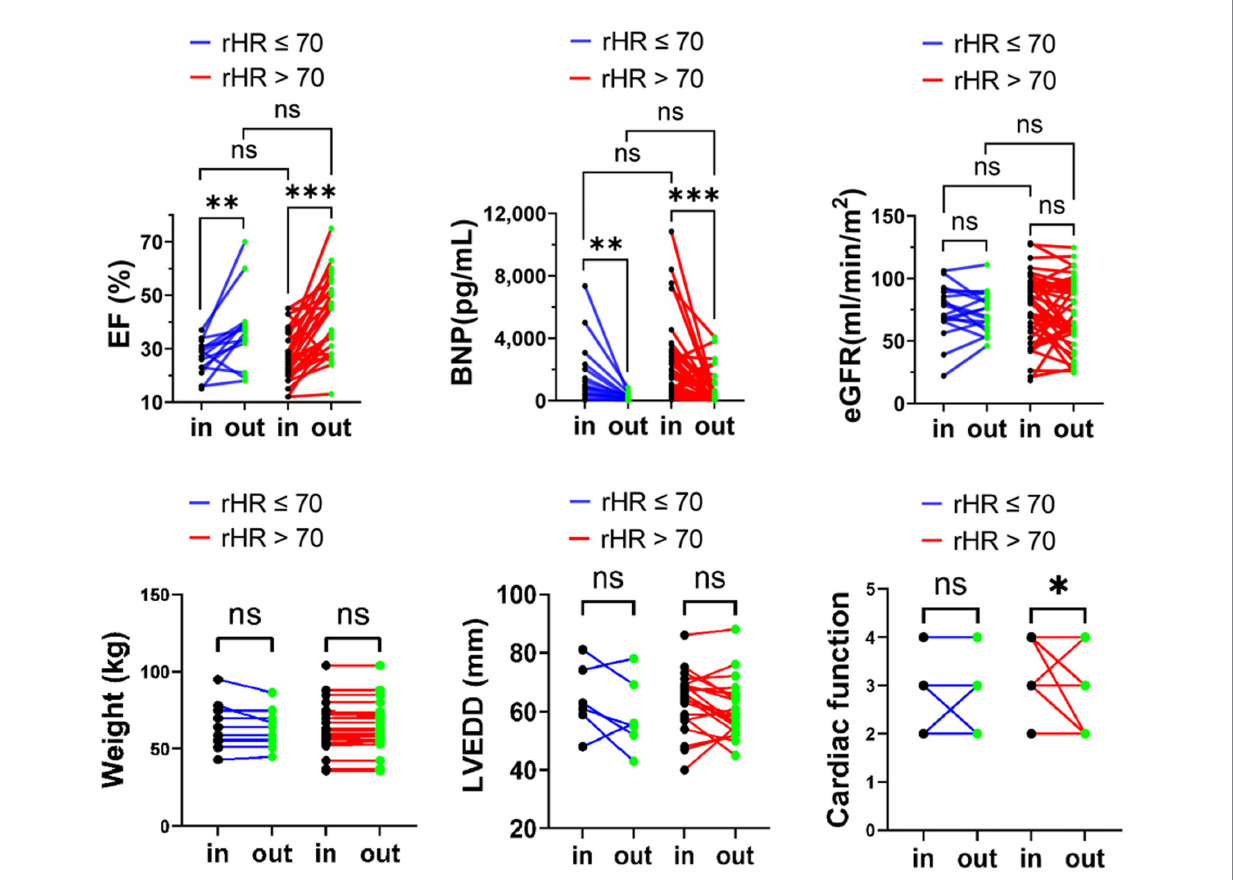
FIGURE 3 eGFR, LVEF, and BNP body weight, LVEDD, NYHA classification variation upon admission and at discharge in advanced HFrEF patients with rHR ≤ 70 bpm or rHR > 70 bpm. * p < 0.05; ** p < 0.01; *** p <